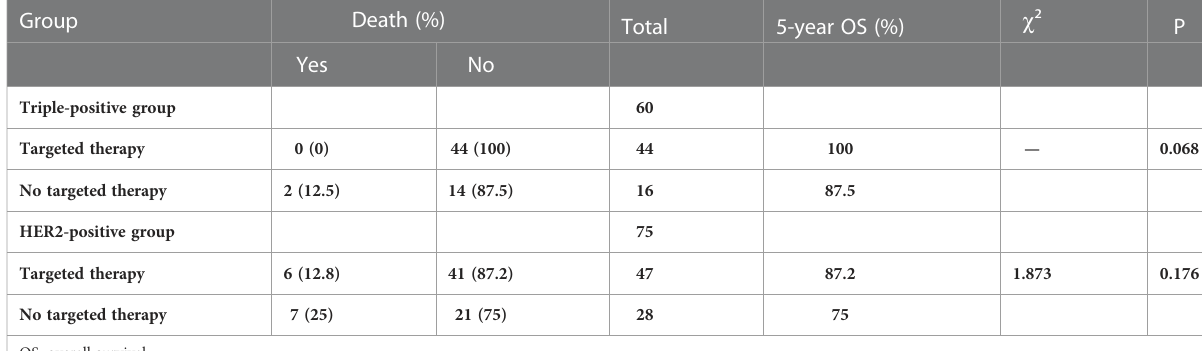
TABLE 7 Survival with targeted drugs in the triple-positive and HER2-positive groups.